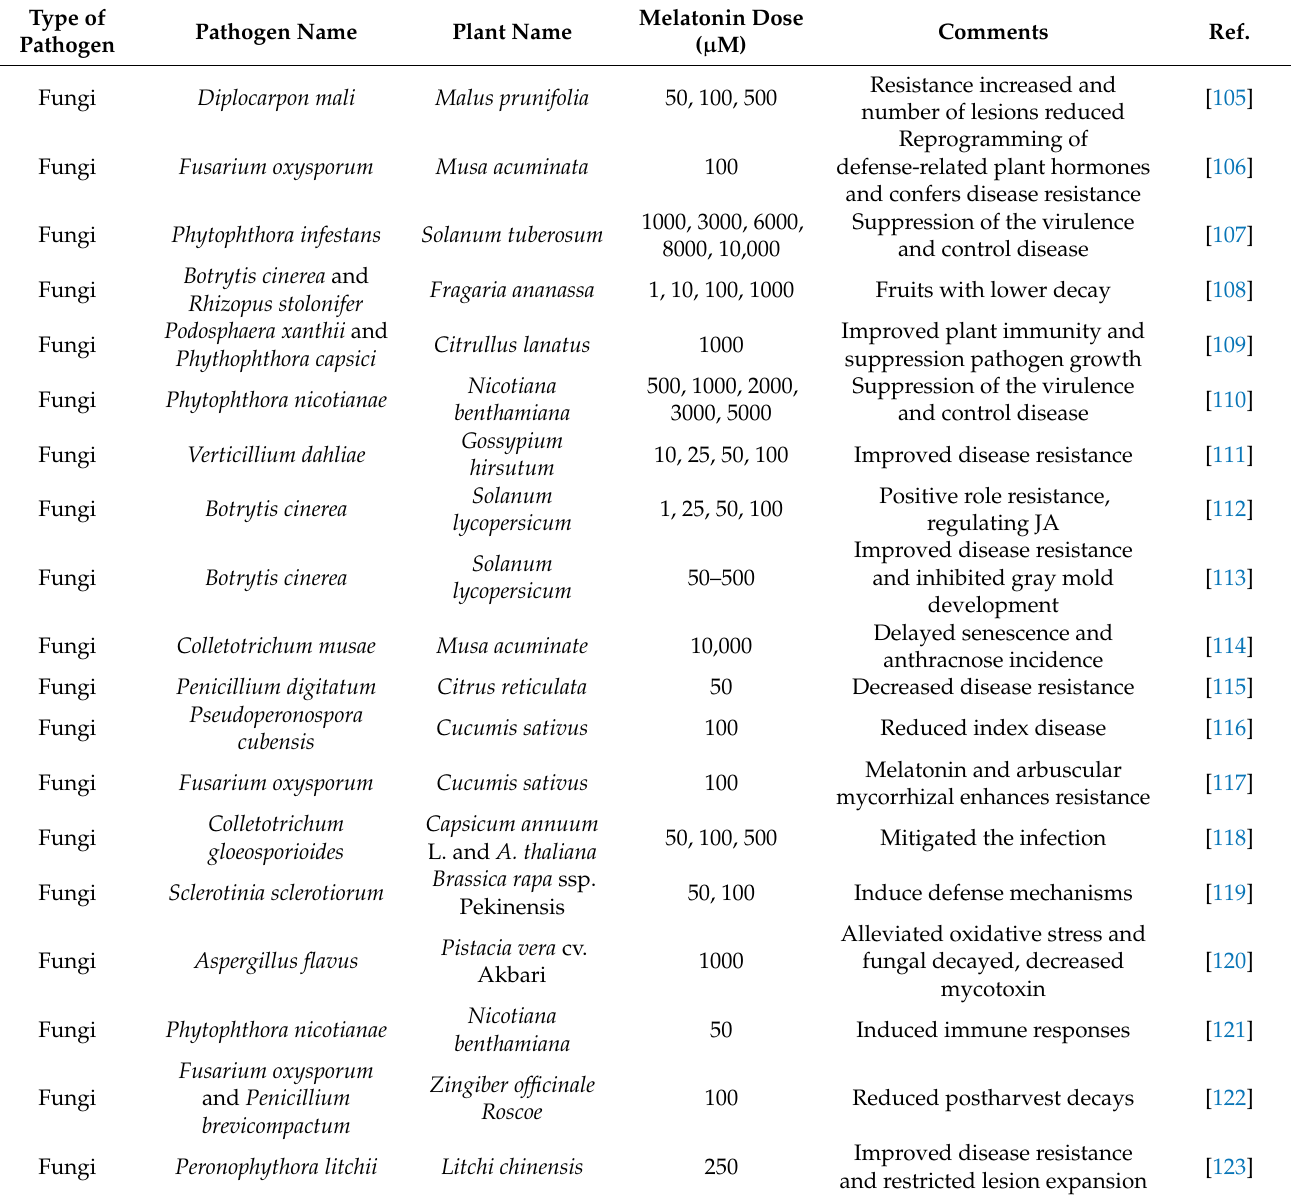
Table 1. Effects of treatment with exogenous melatonin on plants infected by pathogens (fungi, bacteria, and